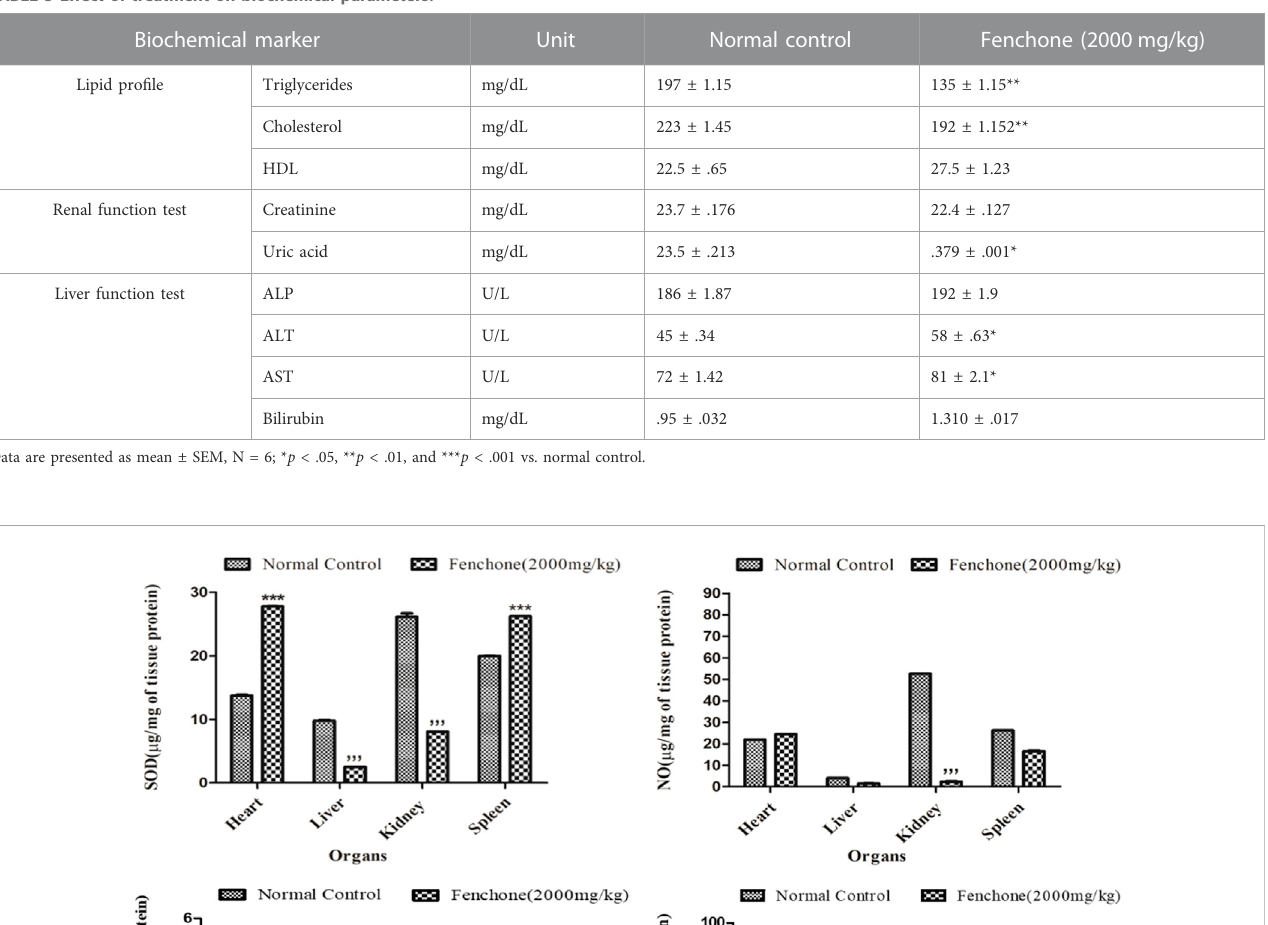
TABLE 5 Effect of treatment on biochemical parameters.